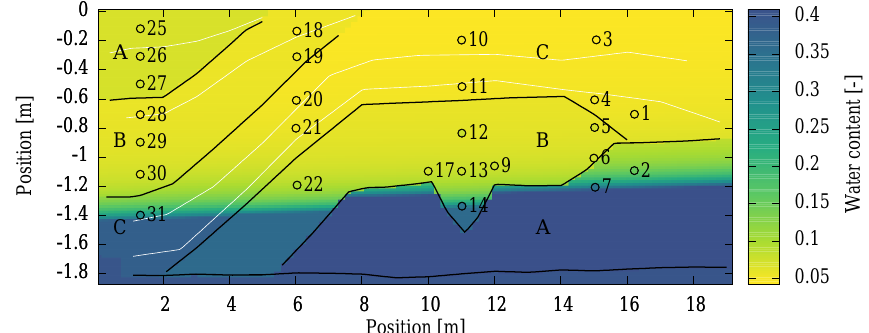
Figure A3. The estimated initial water content distribution is based on the TDR measurement data (Fig. A2, shown as face color of the circled dots). Since the saturated water content θ s is fixed for each material a priori, only TDR sensors in unsaturated material are shown. Due to the orientation of ASSESS (Sect. A1.2), the groundwater table is slightly slanted. The black lines indicate material interfaces, whereas the white lines indicate compaction interfaces, which were introduced during the construction of ASSESS. Note the different scales on the horizontal and vertical